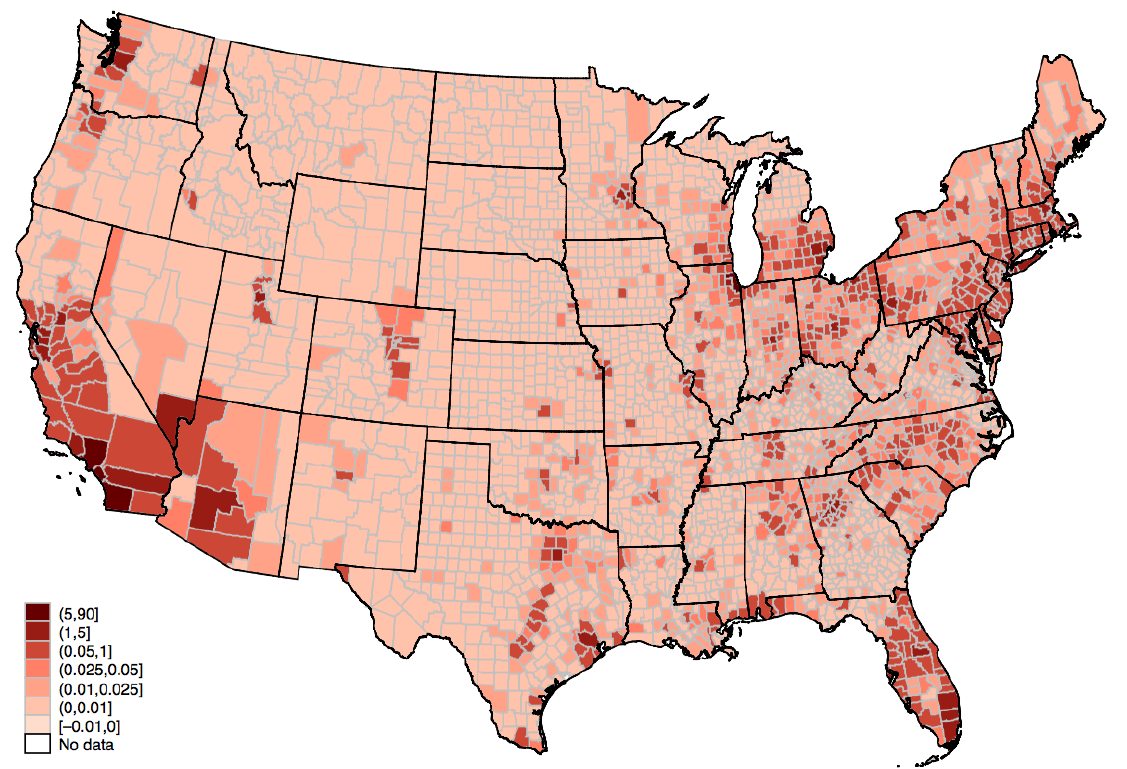
Figure A5. Reduction in deaths received: travel. Notes: Figure shows monthly reduction in expected deaths received in each